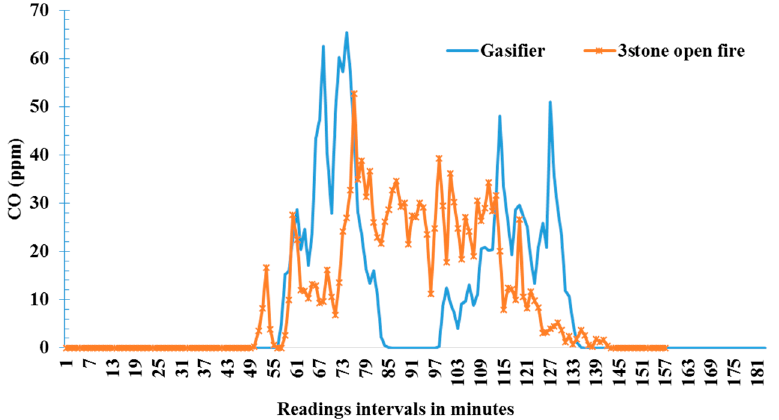
Figure 6. Concentration of CO in the kitchen before, during, and after cooking with three-stone open fire and gasifier in the household No. 14. fire and gasifier in the household No. 14.